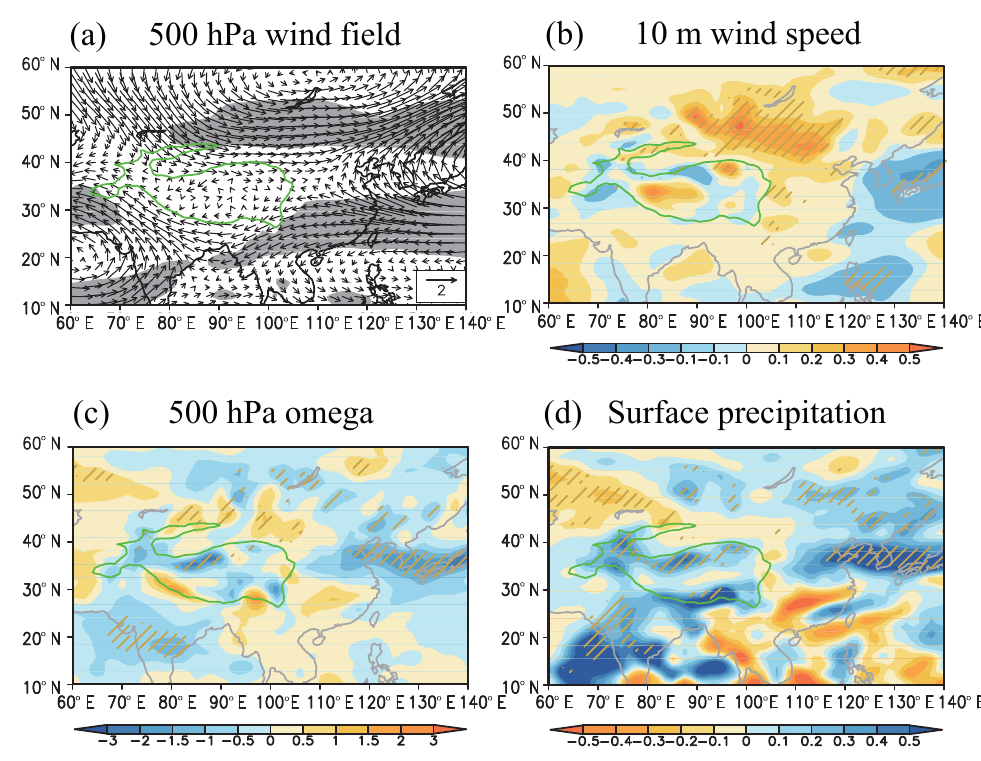
Figure 10. Spatial distribution of the changes in (a) the 500hPa wind field (ms − 1 ), (b) the 10m wind speed (ms − 1 ), (c) the 500hPa omega (0 . 01 × Pas − 1 ) and (d) the surface precipitation (mmday − 1 ) in MAM induced by the dust-in-snow radiative forcing. Here the slanted lines in the grey shaded area represent the grid points where the changes pass the two-tailed t test at the 5% significance level. The green outlined area indicates the plateau above 2500m.